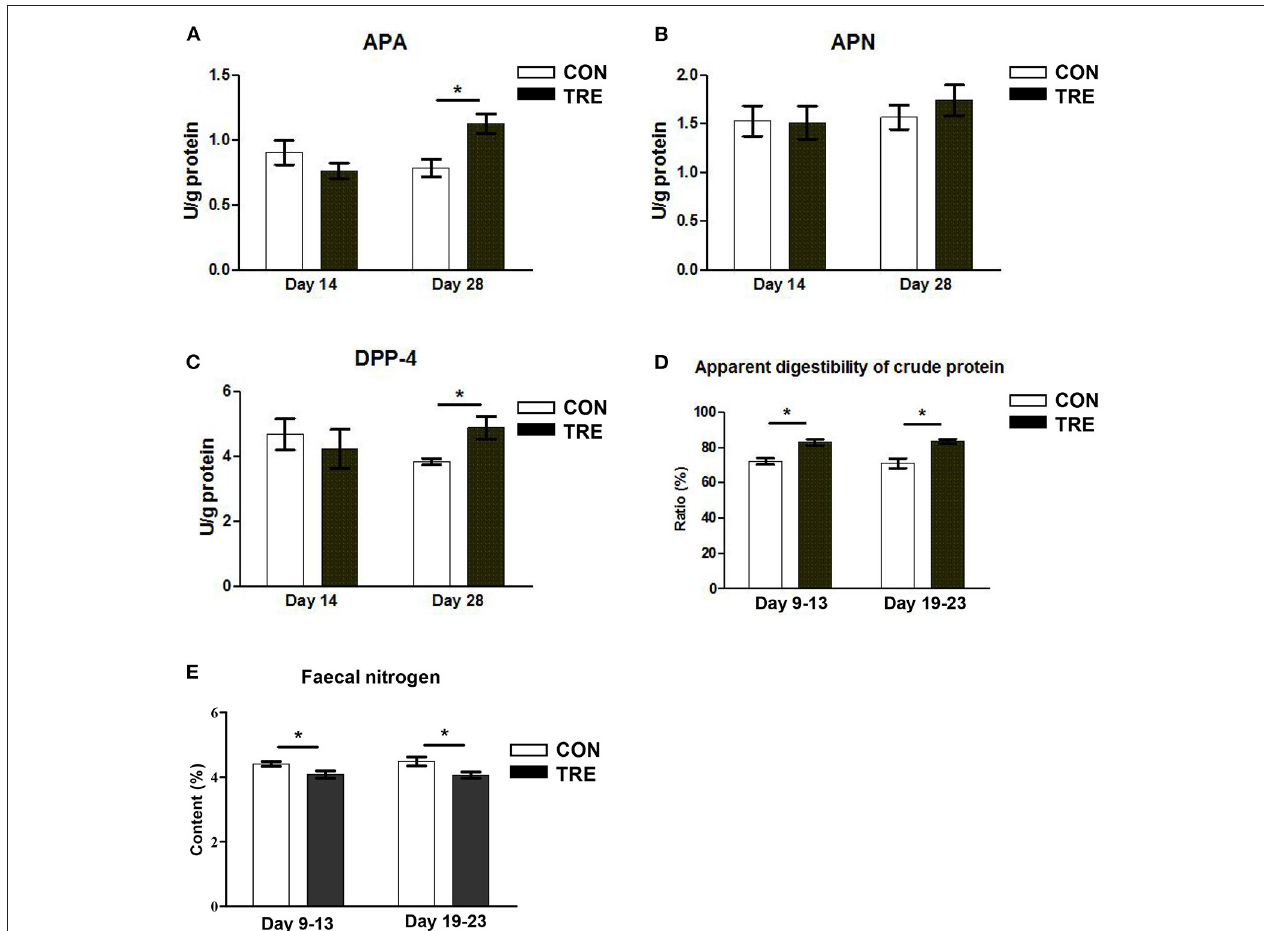
FIGURE 3 | Effect of protein restriction and succedent realimentation on nitrogen nutrient digestibility of jejunum in weaned piglets ( n = 6). (A) Alterations of aminopeptidases A (APA) level in jejunal mucosa on day 14 and 28. (B) Alterations of aminopeptidases N (APN) level in jejunal mocusa on day 14 and 28. (C) Alterations of dipeptidyl peptidase-4 (DPP-4) level in jejunal mucosa on day 14 and 28. (D) and (E) Alterations of fecal apparent digestibility of crude protein and nitrogen content on day 14 and 28. P < 0.05 were considered significant and markers (*) between groups on the same day. CON, control group; TRE, treatment